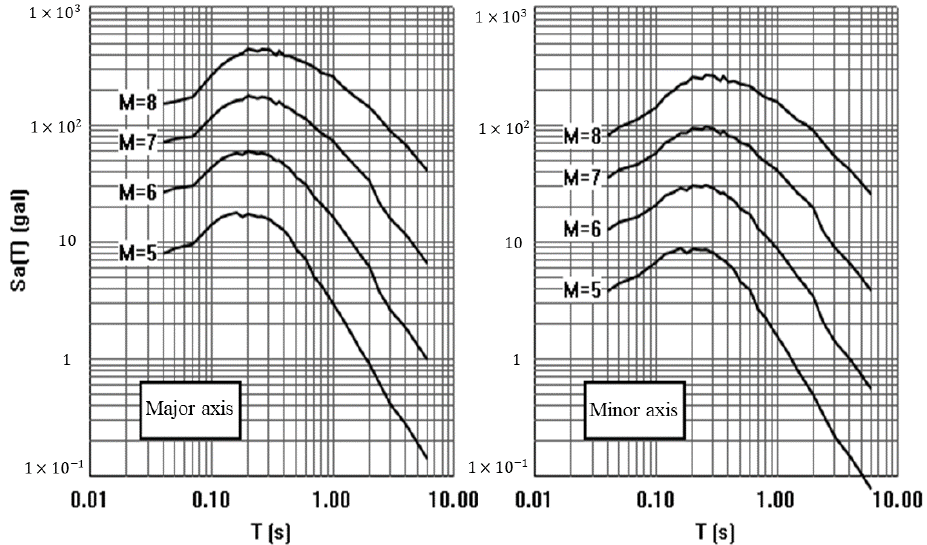
Figure 6. Attenuation curve of the response spectrum of horizontal bedrock acceleration (epicentral distance R = 50 km).